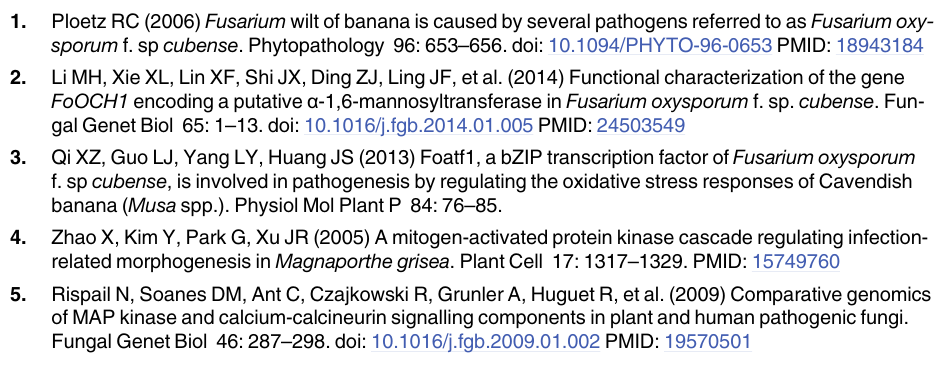
S6 Fig. Expression levels of FoSlt2 , FoMkk2 and FoBck1 gene in WT, corresponding mu- tants Δ FoSlt2 , Δ FoMkk2 and Δ FoBck1 , and corresponding complemented strains Δ FoSlt2 -c and Δ FoMkk2 -c. Gene expression levels are represented relative to WT using quantitative real- time PCR. Error bars indicate the standard error from three replicates. Quantitative real-time PCR analysis was performed with RNA samples of the indicated strains, FoSlt2 gene using primer pair RT-F1/RT-R1 (S3A Fig, S1 Table), FoMkk2 gene using primer pair RT-F2/RT-R2 (S3B Fig, S1 Table), and FoBck1 gene using primer pair RT-F3/ RT-R3 (S3C Fig, S1 Table). The expression levels of FoSlt2 , FoMkk2 and FoBck1 genes were not detected in corresponding mutants Δ FoSlt2 , Δ FoMkk2 and Δ FoBck1 , while the complemented strains Δ FoSlt2 -c and Δ FoMkk2 -c were completely restored to WT levels,